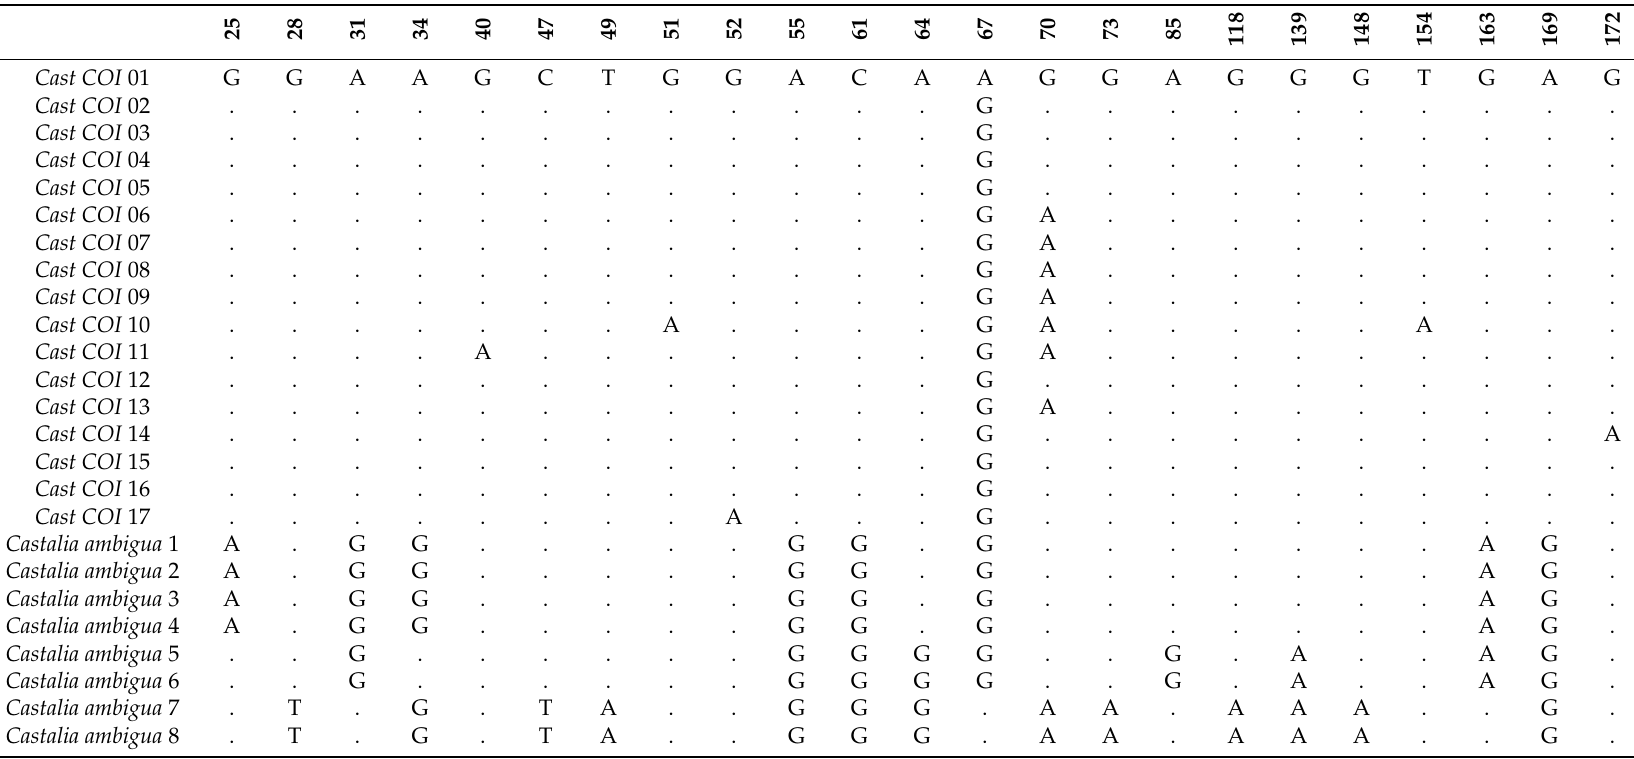
Table 4. Haplotypes for Castalia sp. at the mitochondrial cytochrome oxidase I ( COI ) gene. Haplotypes Cast _ COI _01 through 17 are original data from the Paraguay River basin; C. ambigua 1 through 8 are from the Amazon River basin and were collected by da Cruz Santos-Neto et al. [20]. Numbers refer to nucleotide